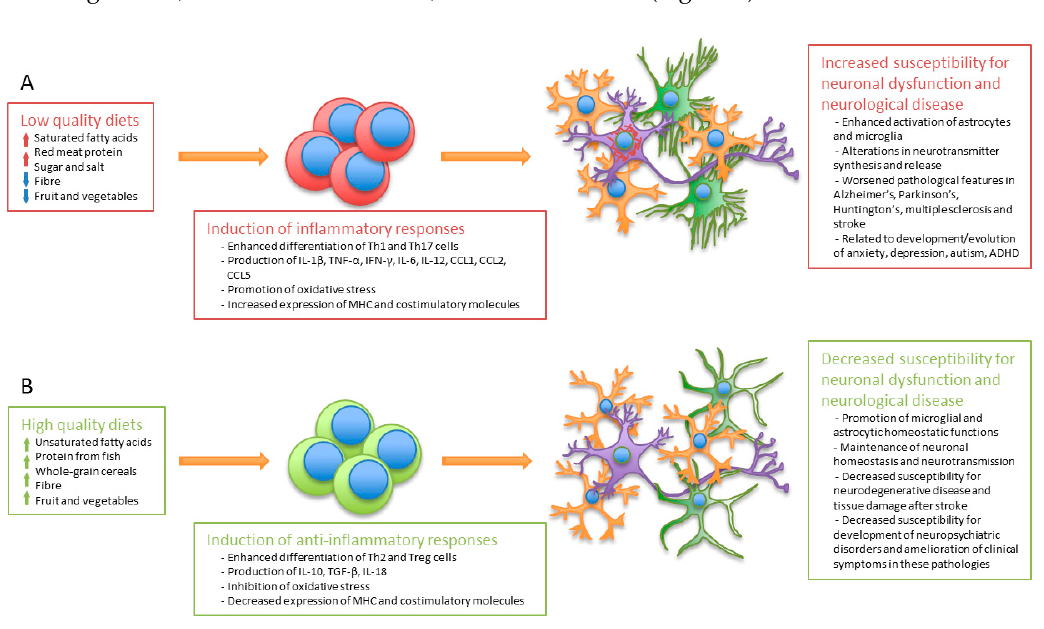
Figure 2. Dietary patterns determine the susceptibility to develop immune dysfunction and neurological abnormalities. Diverse components in diet modulate the differentiation and activation of specific leukocyte subpopulations, promoting pro- or anti-inflammatory functions. The effector functions of activated leukocytes regulate in turn the susceptibility to develop CNS inflammation, metabolic dysregulation, and tissue damage and are, thus, related to the development of neurological and psychiatric disorders. The figure depicts the effects of ( A ) low quality (e.g., western-type diets) and ( B ) high quality (e.g., Mediterranean diets) diets on the immune system and their relationship to the susceptibility for neuronal dysfunction and development of neurological and psychiatric disorders. MHC: Major histocompatibility complex.